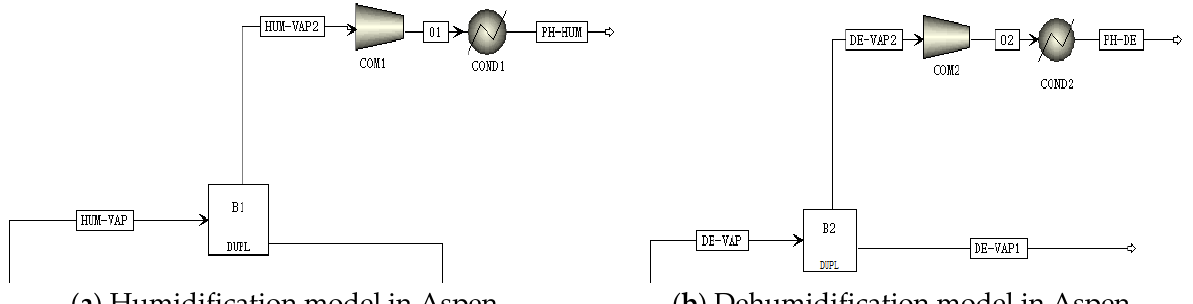
Figure 2. Gas stream pH measure model.